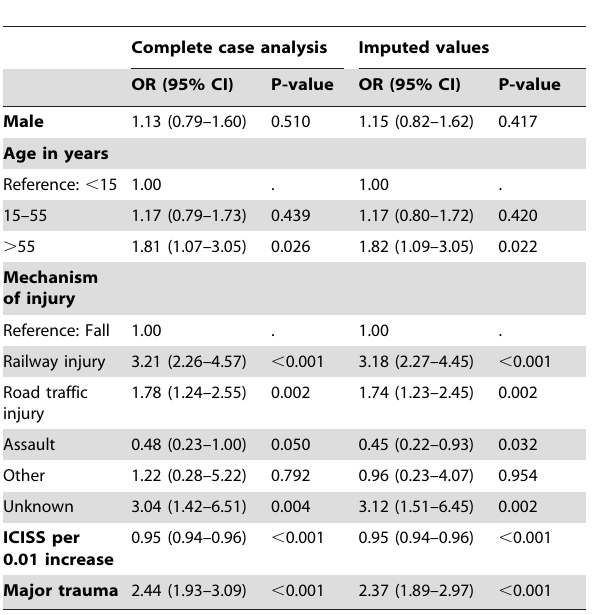
Table 3. Results from univariate logistic regression assessing associations between patient characteristics and early hospital mortality.